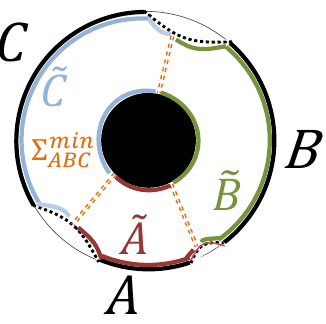
Figure 3 . An example of tripartite entanglement wedge cross-section in a black hole geometry. Each surface of (cid:6) min is ABC